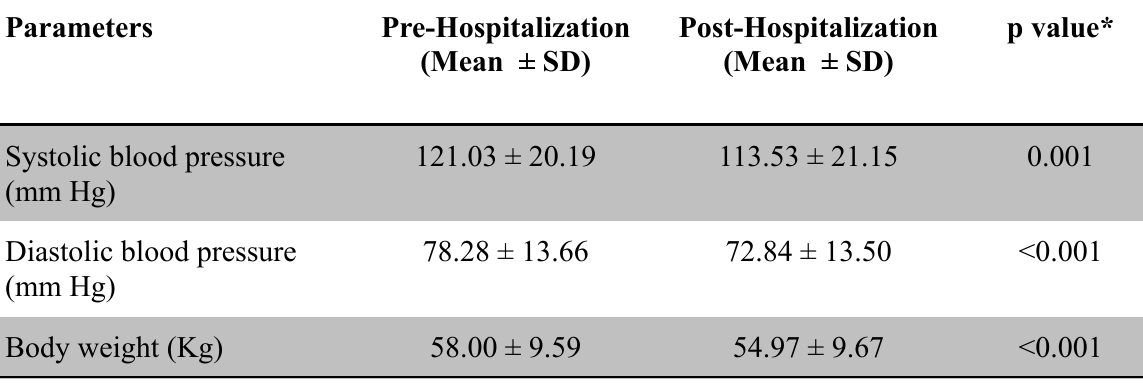
Table 5: Pre- and Post- hospitalization clinical parameters